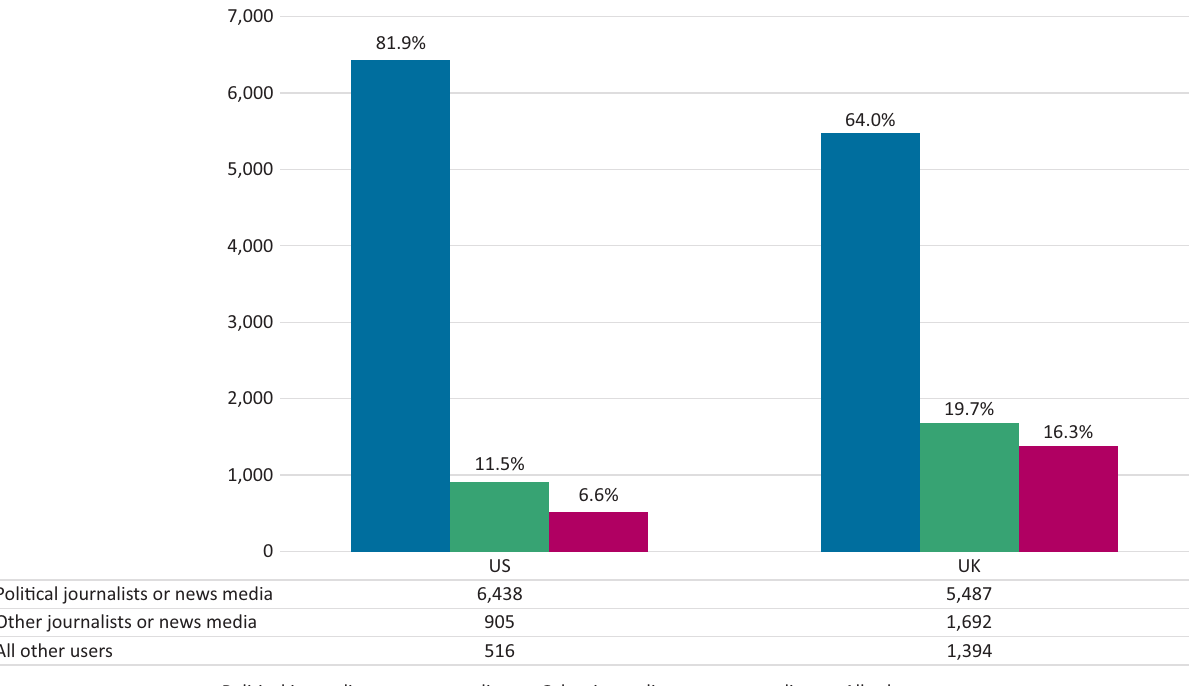
Figure 1. Political journalists’ preferred discussion partners in